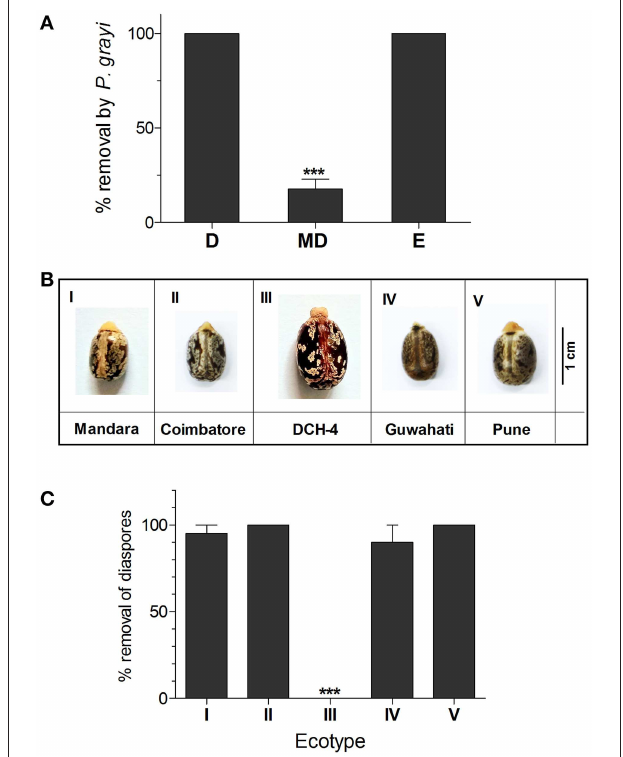
FIGURE 2 | (A) Removal rates of diaspores, seeds and elaiosomes of “Mandara” variety by P. grayi . Data represents mean ± SE. Asterisk indicates significant difference between treatments tested using Tukey’s post-hoc test after one-way ANOVA ( p ≤ 0.01, n = 9) (D, Diaspores; MD, manually detached seeds; E, elaiosomes). (B) Ecotypes used for testing differences in dispersal (C) . Removal rates of diaspores of different ecotypes of R. communis . Data represents mean ± SE. Asterisk indicates significant difference between treatments tested using Tukey’s post-hoc tested after one-way ANOVA ( p ≤ 0.01, n =